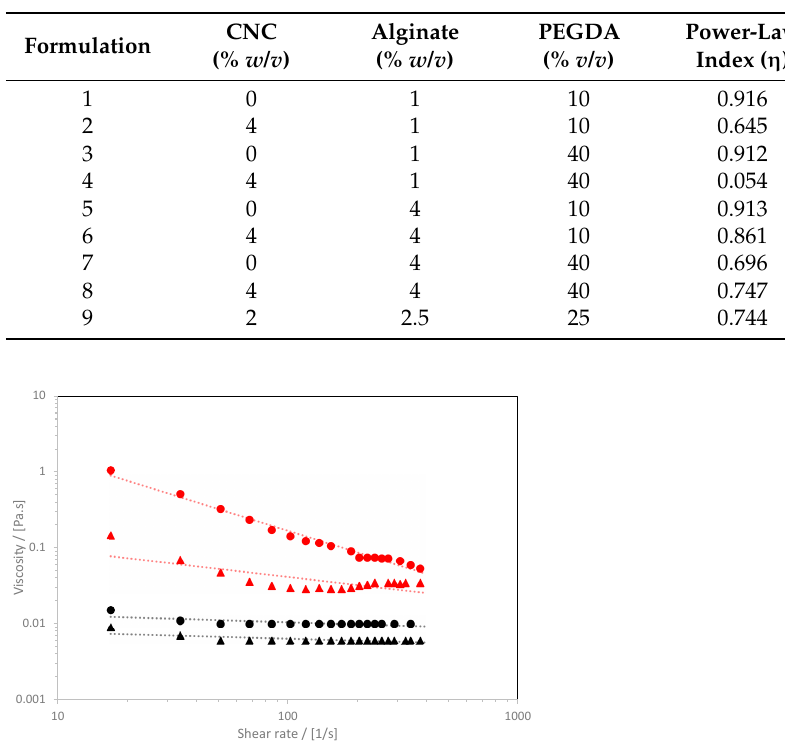
Table 2. Power-law index ( η ) and consistency index (K) for the different CNC/Alg/PEGDA pre-gel formulations.